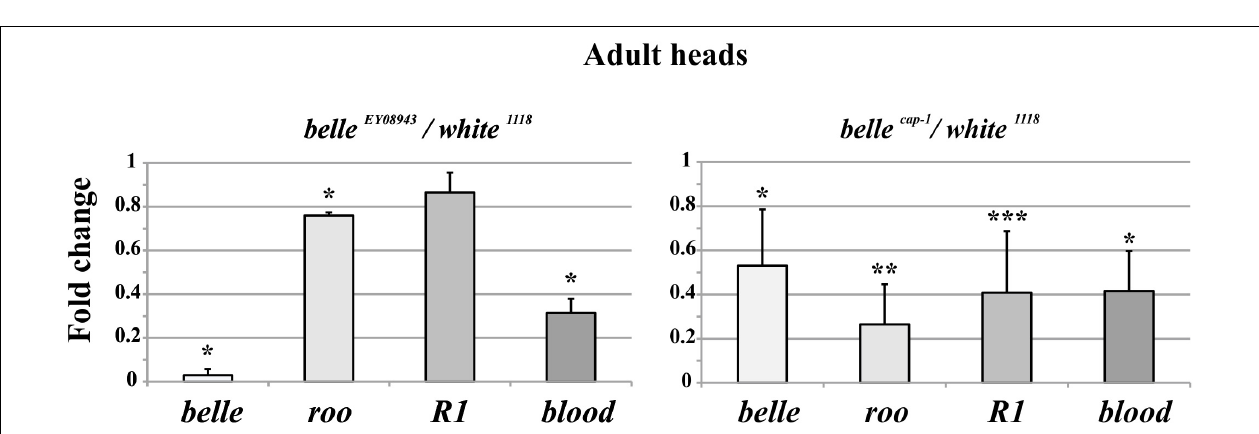
FIGURE 8 | Altered TEs expression in belle mutant heads. qRT-PCR on heads from belle EY 08943 , belle cap − 1 , and white 1118 flies reared in 12:12 LD cycles and collected at ZT3. Represented are relative amount of belle and three transposable elements (TEs) ( roo, R1, and blood ) in belle EY 08943 (A) and in belle cap − 1 (B) compared to white 1118 control, to which an arbitrary value of 1 was assigned. Represented are mean ± SD of three biological replicates. ∗∗∗ p < 0.005, ∗∗ p < 0.01, ∗ p <